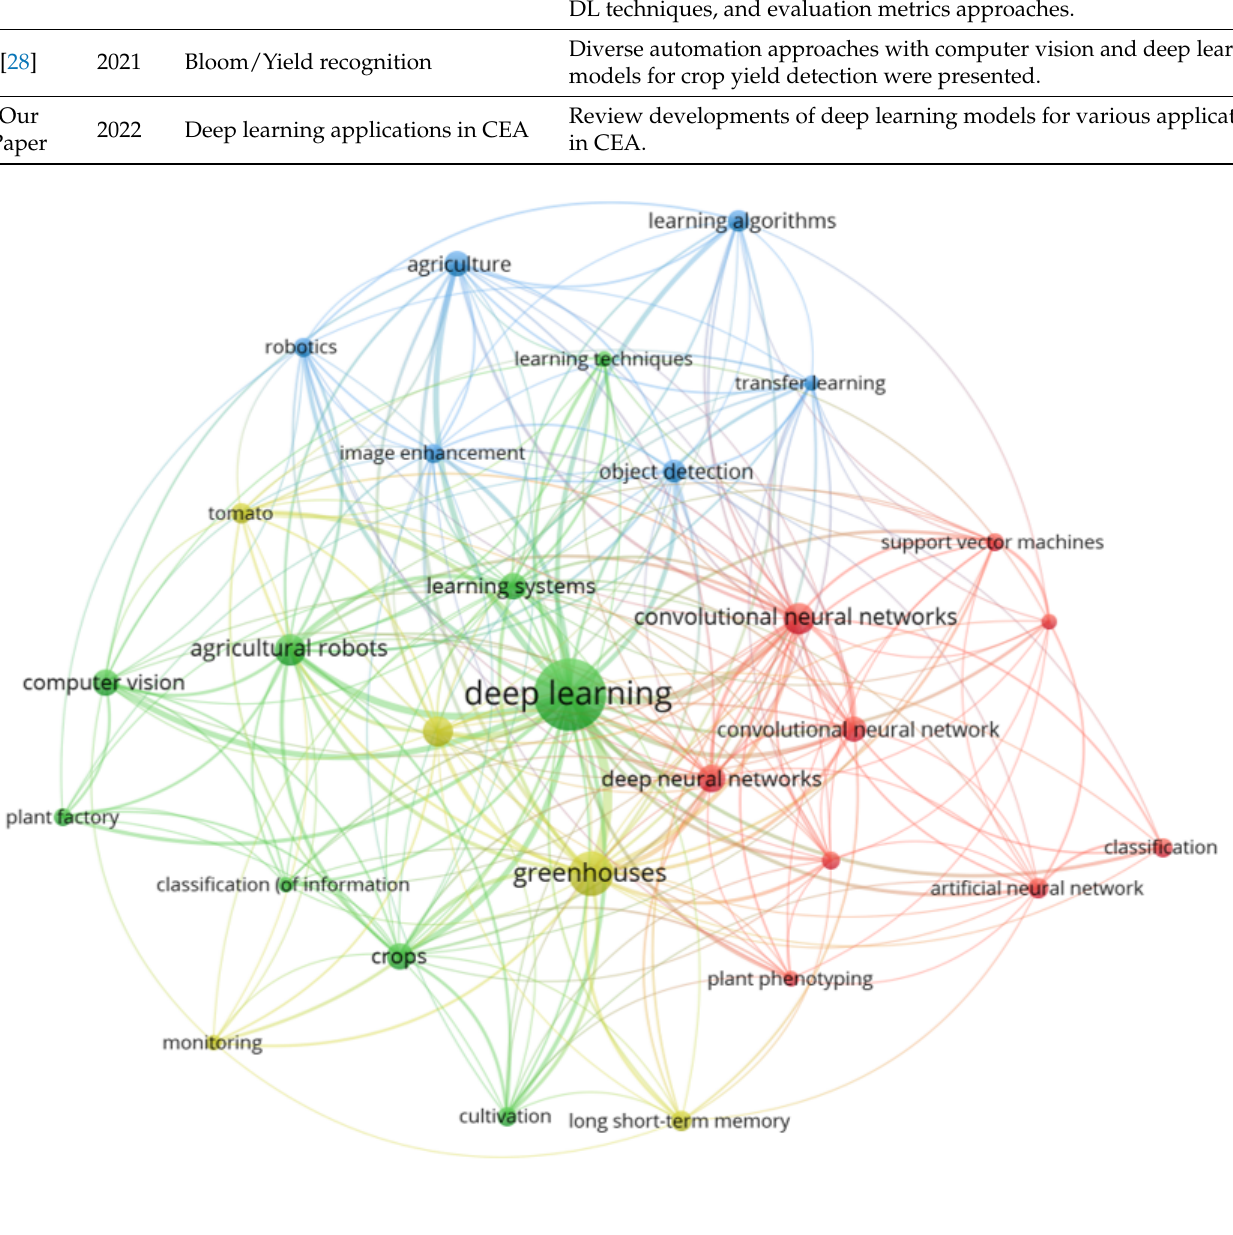
Figure 1. Bibliometric visualization produced by VOSviewer Software using the author’s